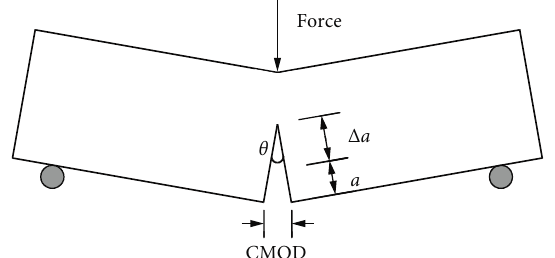
Figure 5: Dynamic fracture model of the specimen under TPB fracture